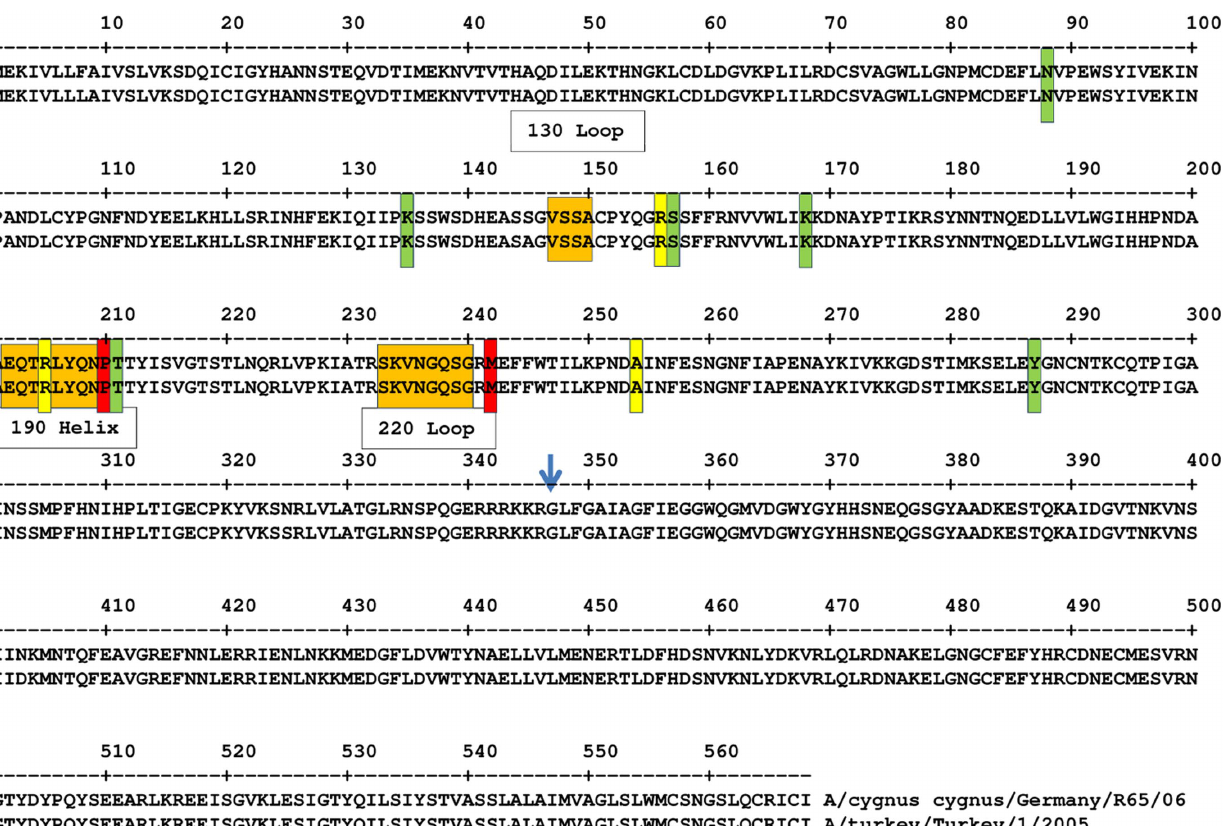
Figure 4. Comparison of positions of HA amino acid mutations found in CVI P42 and FLI P30esc. Positions of mutations in the HA protein found in CVI P42 (yellow bars) and FLI P30esc isolates (green bars) relative to the HA protein sequences of A/turkey/Turkey/1/2005 and A/Cygnus cygnus/Germany/R65/2006. Red bars indicate the two amino acid mutations (P210S, M242I) found in common between CVI P42and FLI P30esc isolates. The positions of the 130- and 220-loop and 190 helix are shown in orange boxes. The blue arrow indicates the proteolytic cleavage site between HA1 and HA2. Numbering according to the A/turkey/Turkey/1/05.